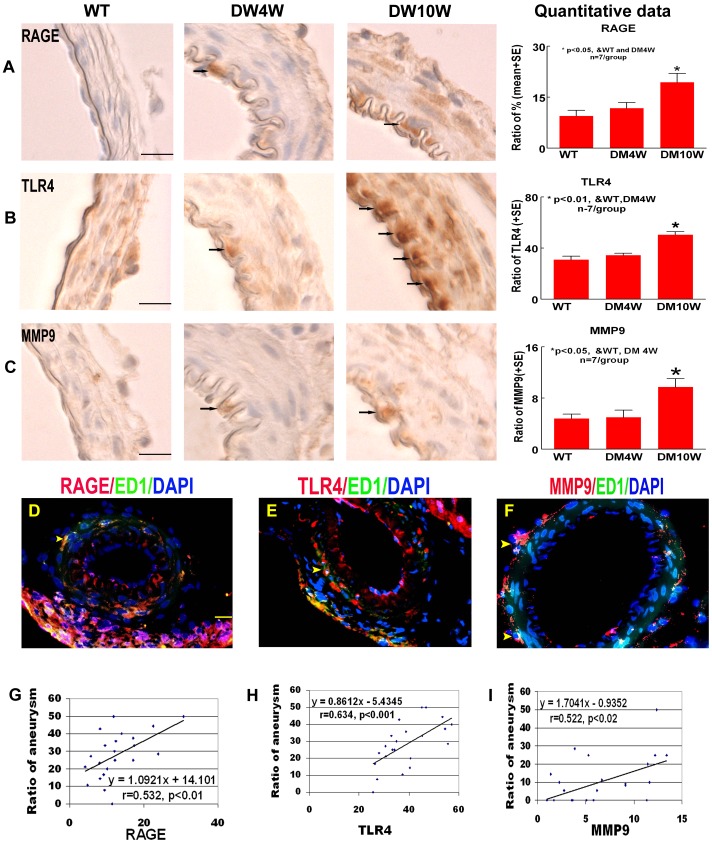
T1DM increases RAGE, MMP9 and TLR4 expression.RAGE, TLR4 and MMP9 is correlated with aneurysm formation in T1DM rats. A–C: RAGE (A), TLR4 (B) and MMP9 (C) immunostaining and quantitative data. T1DM significantly increased RAGE, MMP9 and TLR4 expression compared to non-DM rats. Arrows indicate the positive cells in the arterial wall. D–F: Double immunostaining ED1 with RAGE (D), TLR4 (E) and MMP9 (F). MMP9, TLR4 and RAGE expression is colocalized with ED1. Arrow heads indicate the positive cells in the arterial wall. G–I: Correlation analysis of aneurysm formation with RAGE (G), TLR4 (H) and MMP9 (I). Aneurysm formation significantly correlated with RAGE, TLR4 and MMP9 expression. Scale bar in A, D, 20 µm.